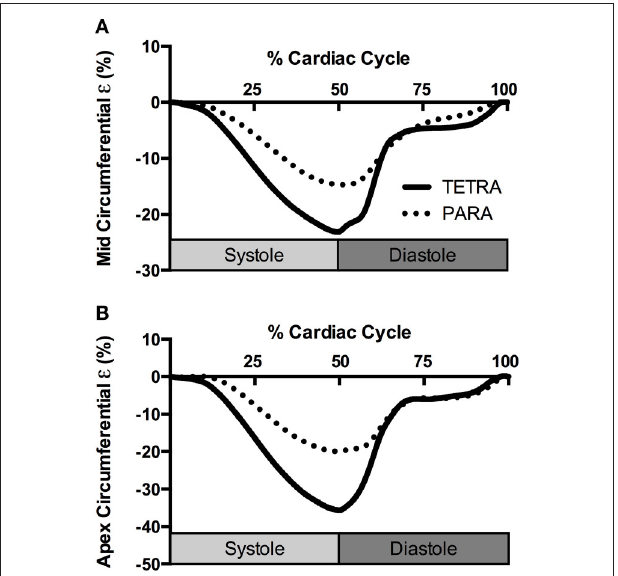
FIGURE 2 | Group averaged circumferential strain ( ε ) traces at the level of the papillary muscle (A) and apex (B) for TETRA (solid line) and PARA (dotted line), normalized to percentage of the cardiac